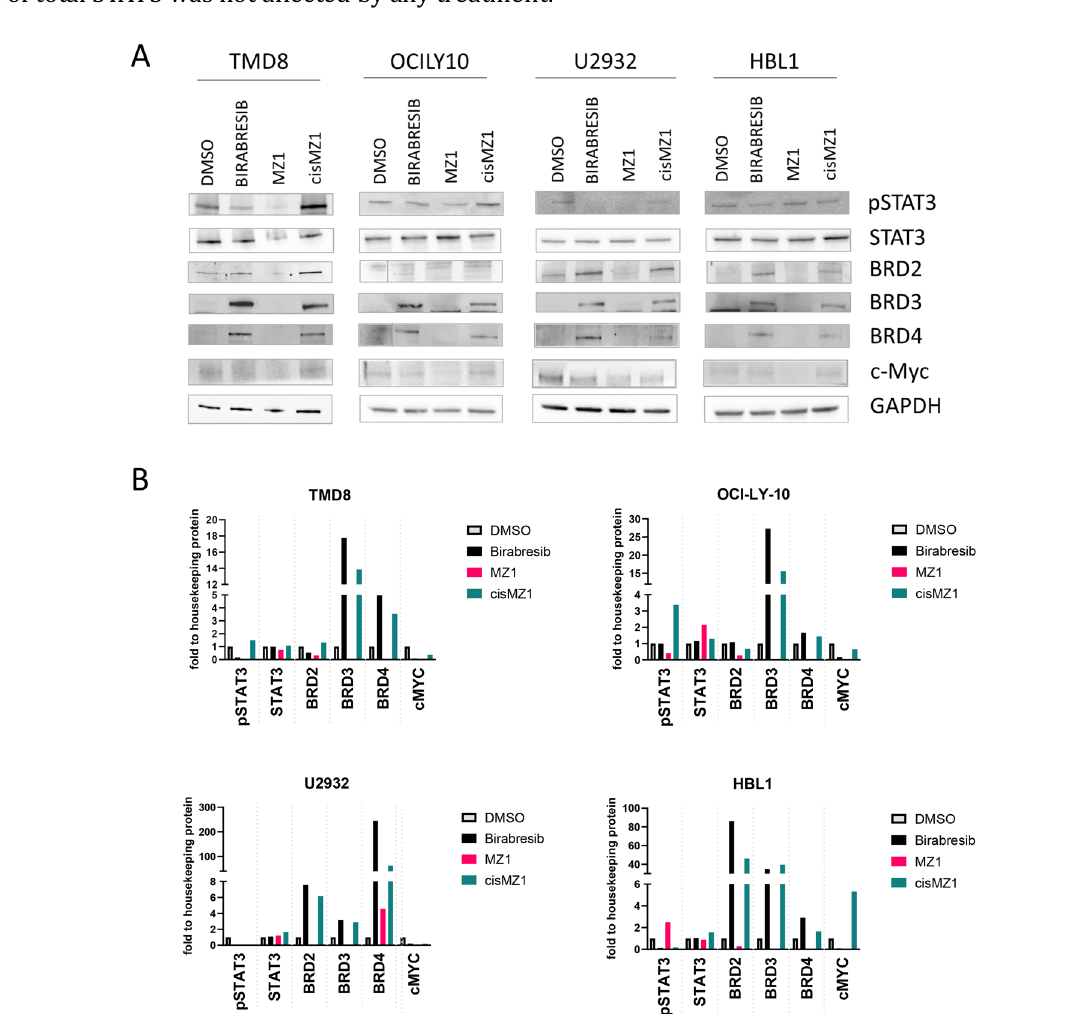
Figure 2. BRD proteins, MYC and pSTAT3 immunoblotting after birabresib or MZ1 treatment. Four ABC-DLBCL cell lines were treated with 500 nmol/L of DMSO, birabresib, MZ1 or cisMZ1. Protein extraction was performed after 4 h of exposure to the compound. GAPDH was used as a loading control. A. Representative immunoblottings; B. relative quantification of protein